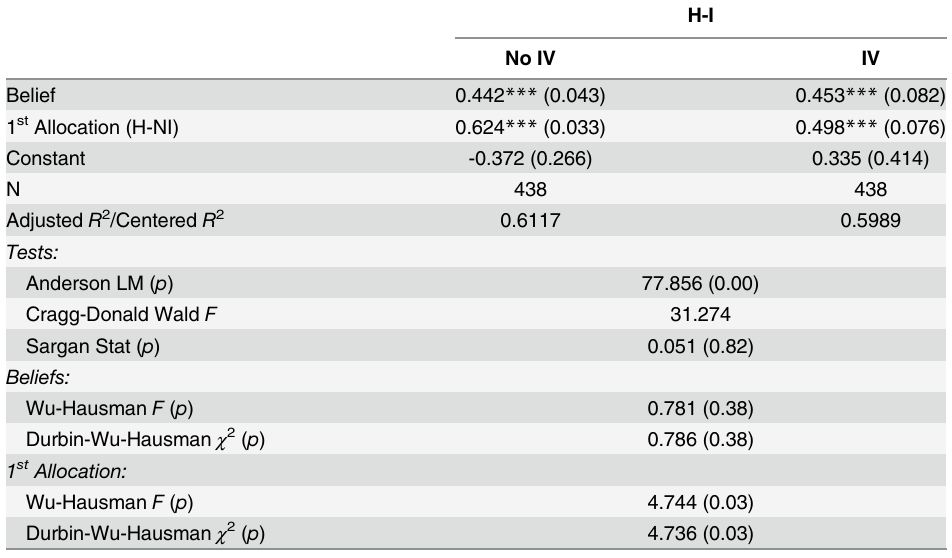
Table 5. Relationship between Allocations, Beliefs and History: with and without Instruments.